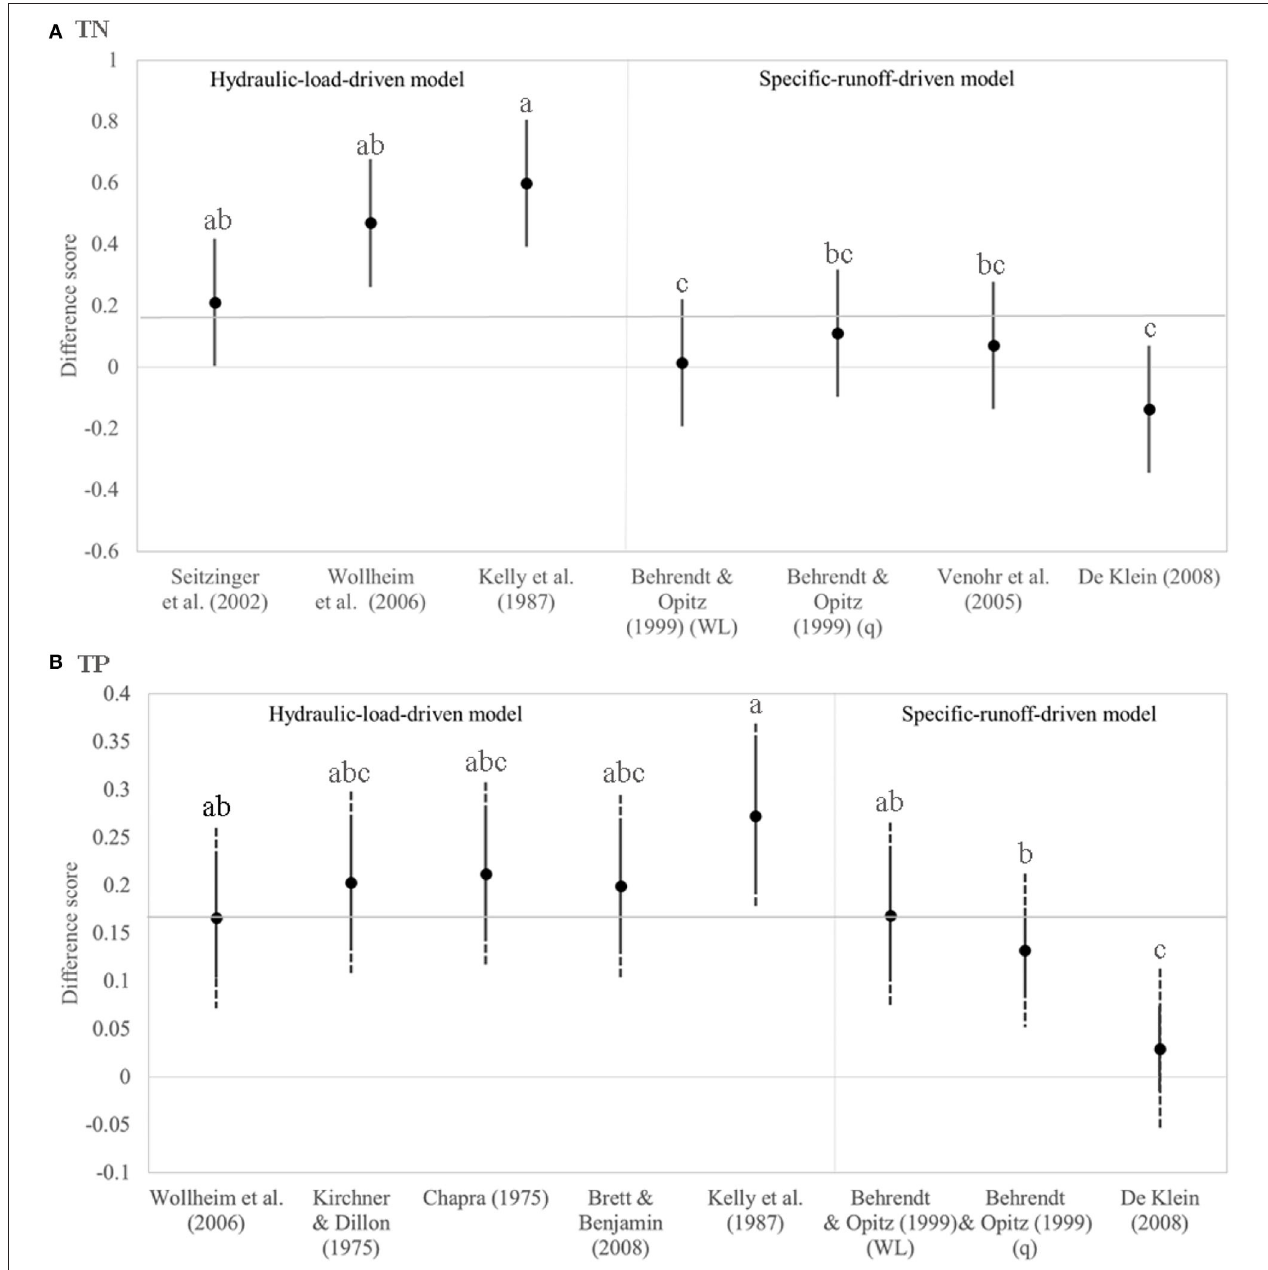
FIGURE 7 | Difference score between simulated and observed concentration for (A) TN and (B) TP among different retention models. Black points are the average difference. The length of the “wings” (shown as black lines around the average) equals SE · q α , k , ν with critical value q α , k , ν and standard error SE determined by Tukey’s HSD or Games-Howell post-hoc test. The solid lines show the minimal SE i , j · q α , k , ν and the dashed lines of the wings indicate the range of pairwise SE i , j · q α , k , ν from the minimum to the maximum. Different letters a, b, c on top of the wings identify significant differences ( p < 0.05) in concentration among the retention